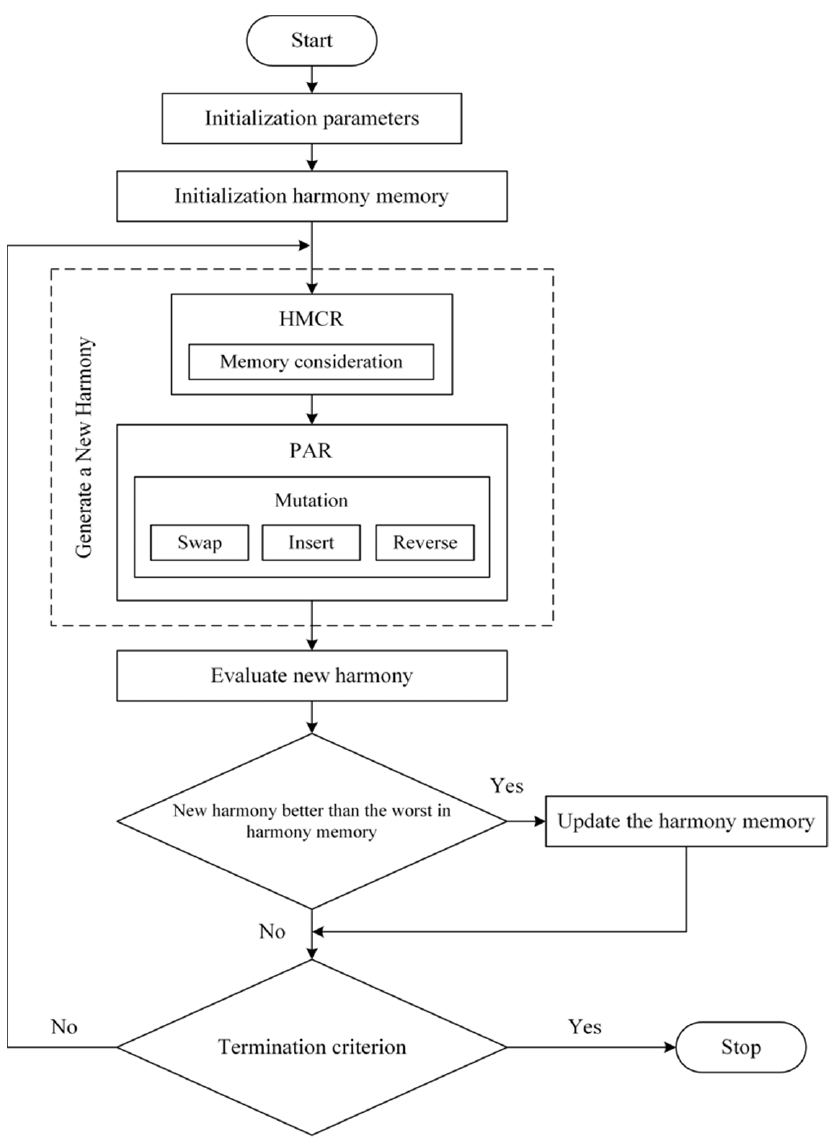
Figure 2. Mutation-based harmony search algorithm.